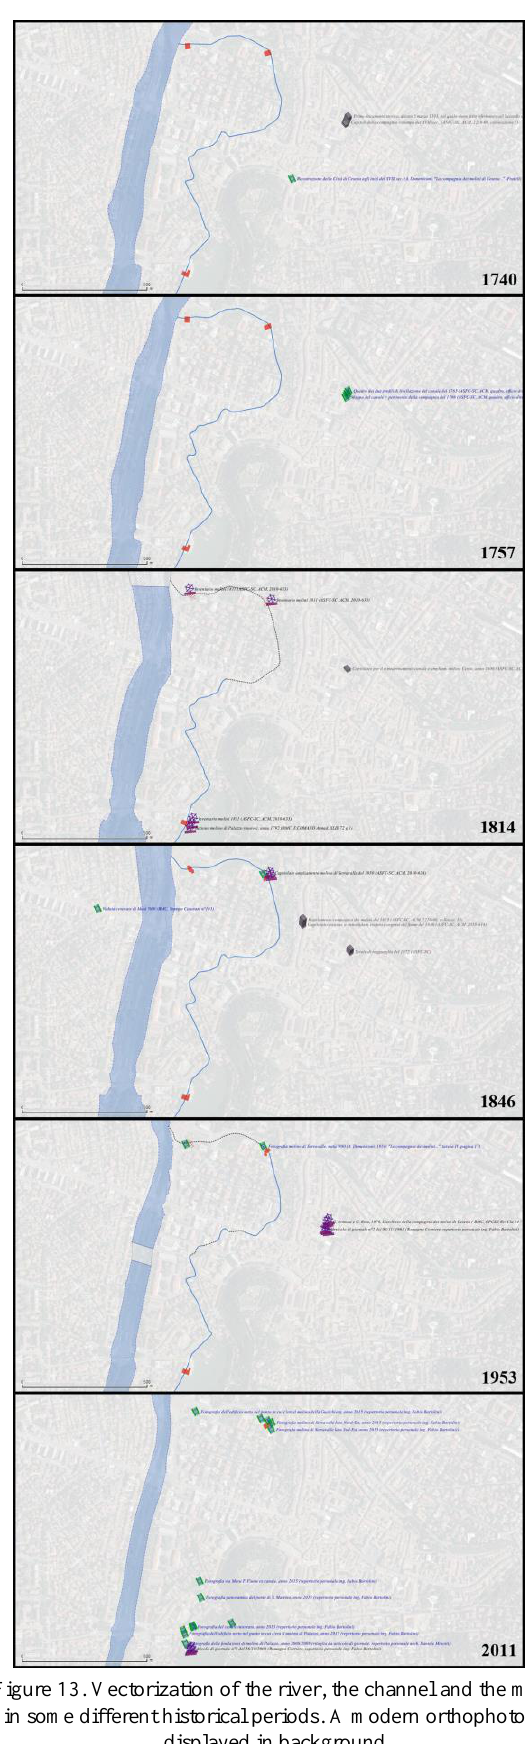
Figure 13. Vectorization of the river, the channel and the mills in some different historical periods. A modern orthophoto is displayed in background